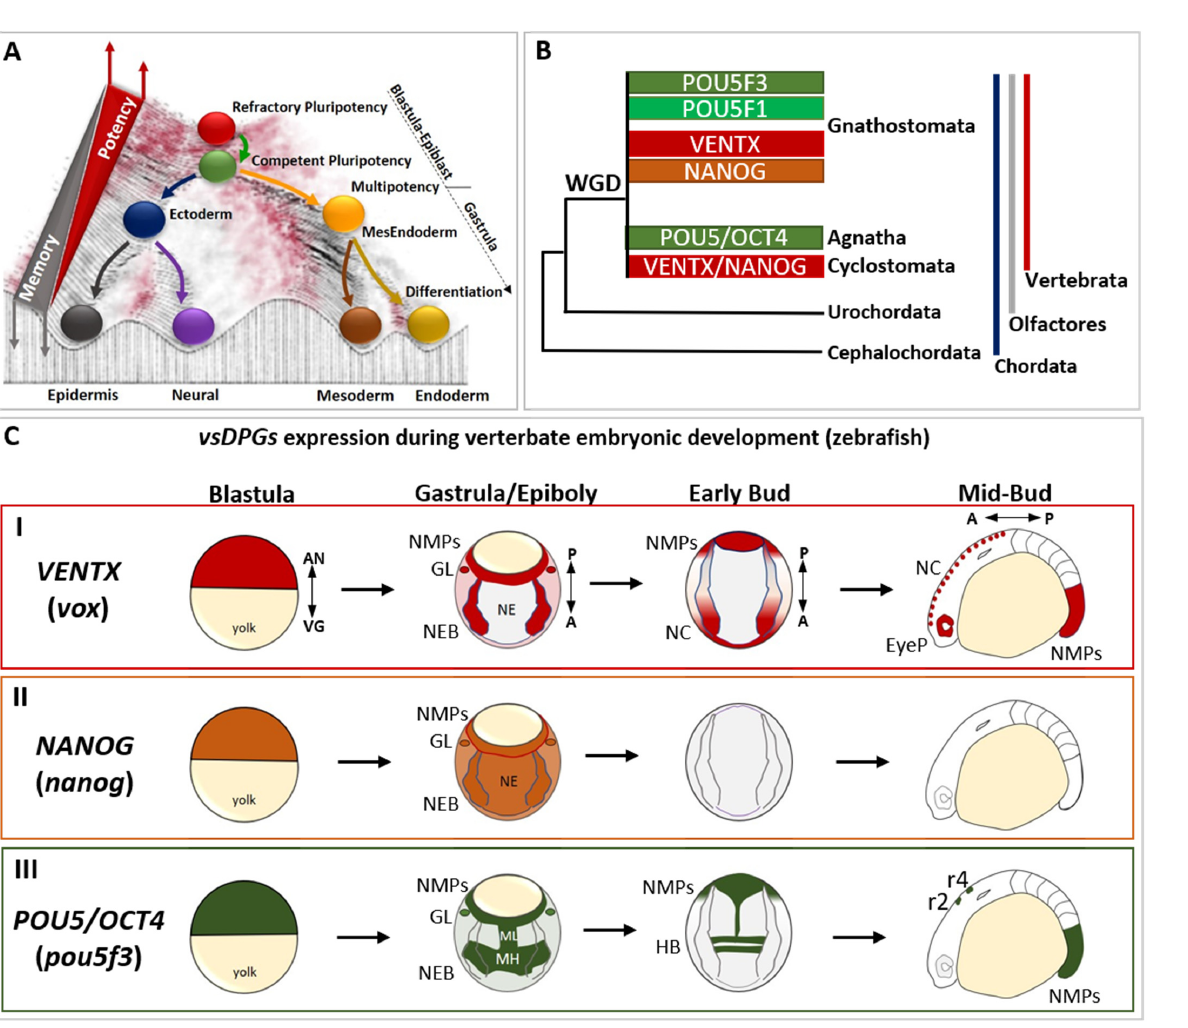
Figure 1. The evolutionary history and the developmental expression of vertebrate-specific devel- opmental potential guardians (vsDPGs) VENTX / NANOG and POU5 / OCT4. ( A ) Modified Wadding- ton’s epigenetic landscape illustrating the cell’s developmental potential changes during development. Cells are represented as balls rolling down a valley, which metaphorically represent the embryonic development continuum . At the top of the hill there are refractory pluripotent stem cells (PSCs; red ball), which represent blastula/epiblast cells in vivo. Once PSCs became competent to respond to differentiating cues (green ball), embryonic cells exit pluripotency and commit into embryonic